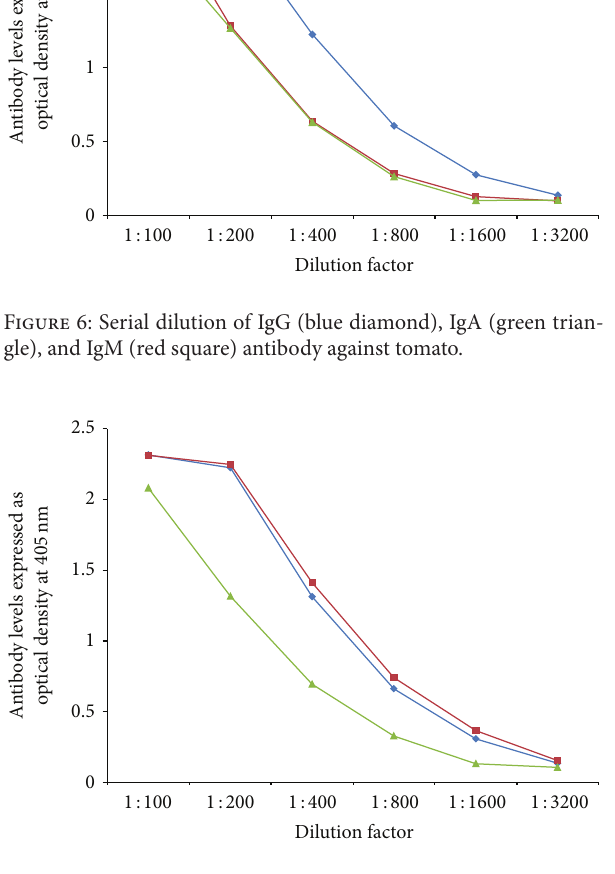
Figure 7: Serial dilution of IgG (blue diamond), IgA (green trian- gle), and IgM (red square) antibody against soy.